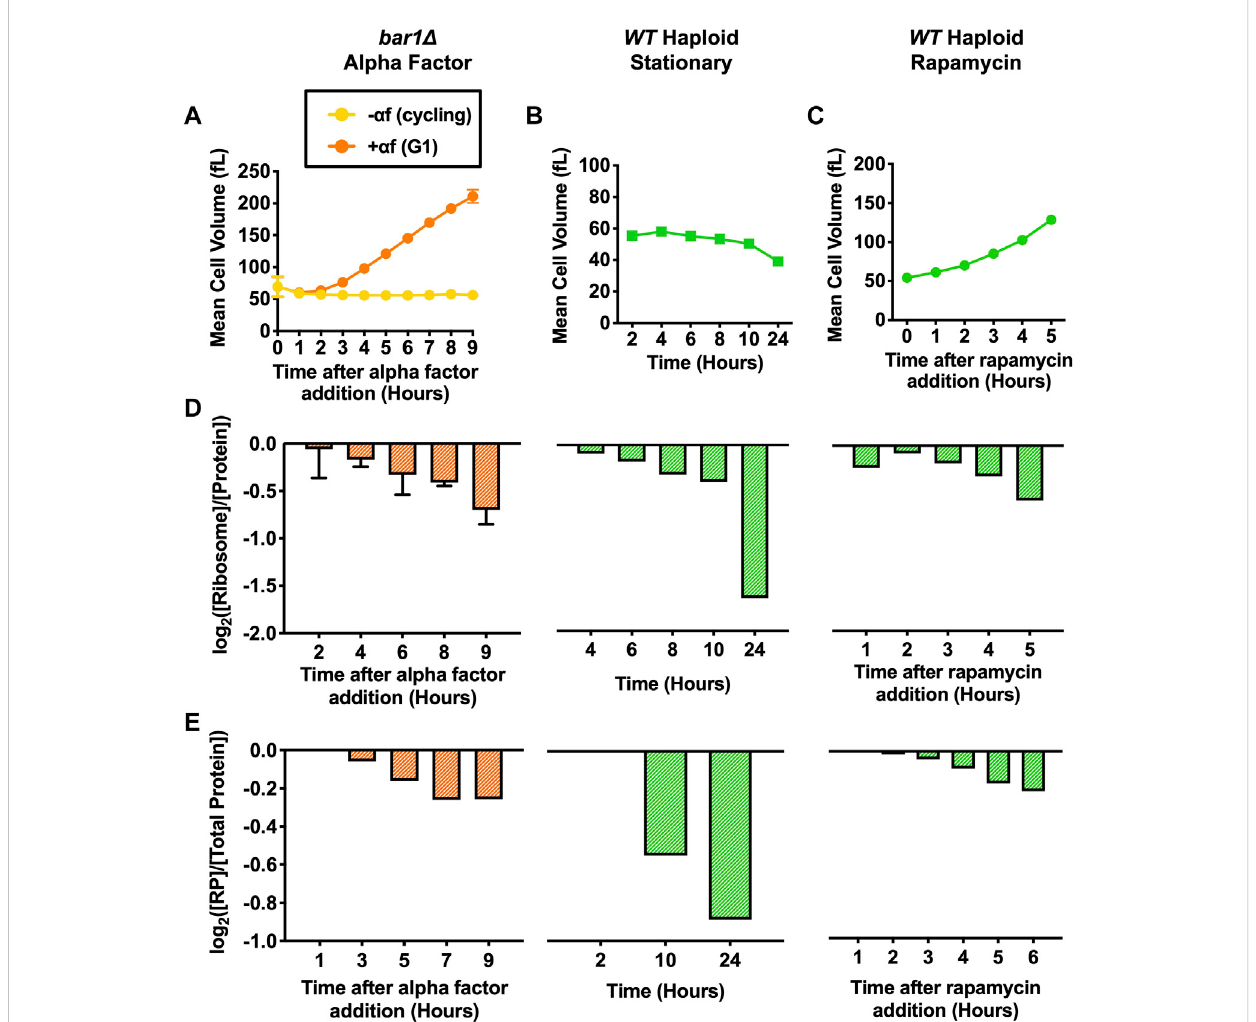
FIGURE 2 Protein and ribosome quanti fi cation of cells arrested in G1 with various methods. For alpha factor experiments, bar1 Δ (A2589) cells were grown to logphaseinYEPDat30 ° C.Cellswerethendividedintotwoculturesandgrown for9 hat30 ° C.5 μ g/mLalphafactorwasaddedtooneculture(+ α f)while the equivalent volume of DMSO was added to the other (- α f). 2 μ g/mL of alpha factor (+ α f) or the equivalent volume of DMSO (- α f) was re-added every 2 h. For stationary phase experiments, WT haploid (A2587) cells were grown in YEPD for 24 h at 30 ° C. For rapamycin experiments, WT